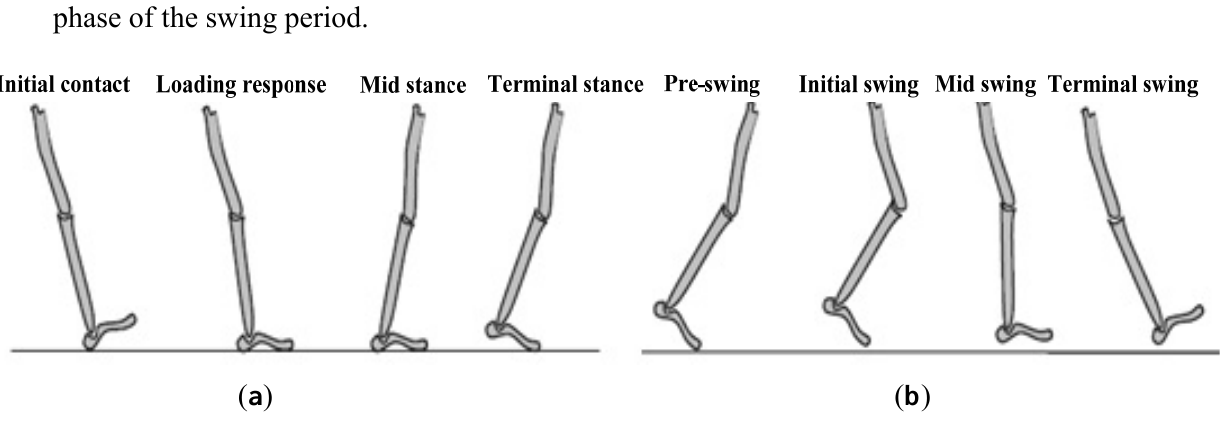
Figure 1. Gait phases in a normal gait cycle. ( a ) Gait phases of the stance period; ( b ) Gait phase of the swing